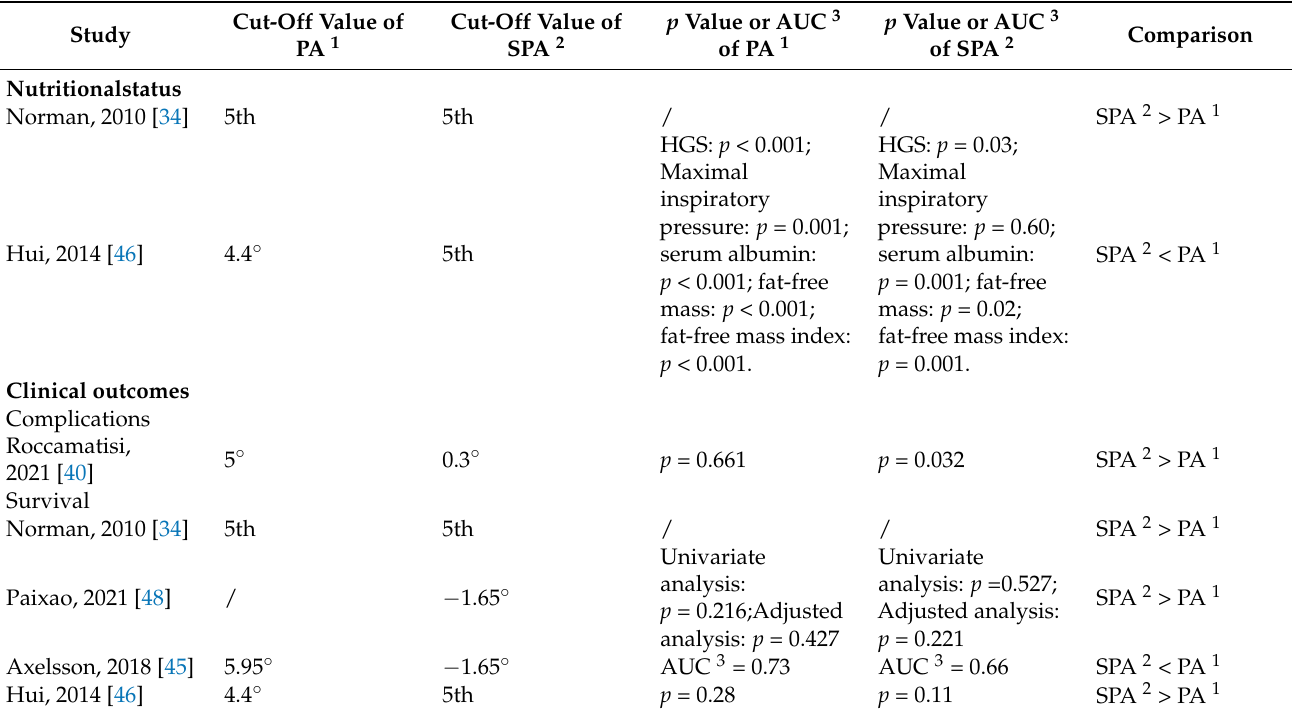
Table 7. Comparison of the Predictive Ability of SPA and